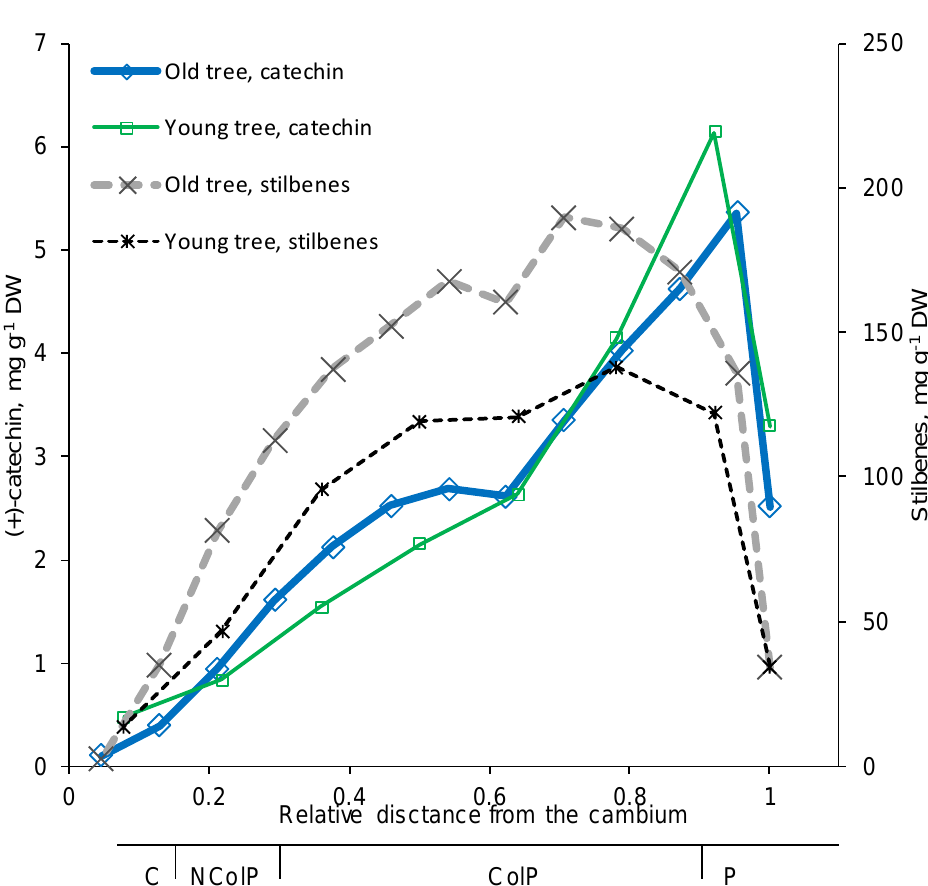
Figure 5. Constitutive radial changes in ( + )-catechin and stilbene glucoside amounts (sum of astringin and isorhapontin) across the mature Norway spruce phloem of an older and a younger non-treated tree, as analyzed by GC-FID. Each data point represents a tangential section (250–450 µ m thick) representative of di ff erent phloem zones: C, cambium; NColP, noncollapsed phloem; ColP, collapsed phloem; P, periderm.